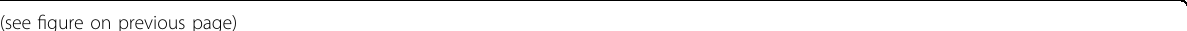
Fig. 4 ADEs promote EMT of primary tumor cells. Primary tumor cells extracted from two patients were treated with 0 μ g, 50 μ g, or 100 μ g of #7 ADEs. a Representative images of morphological changes in primary tumor cells. Scale bar, 100 μ m. b Representative images of in vitro transwell migration assays of primary tumor cells. Scale bar, 100 μ m. c The numbers of migrated cells in transwell migration assays were counted and are shown as histograms. d Representative images of in vitro wound-healing assays of primary tumor cells. Scale bar, 200 μ m. e The areas of wound closure were measured and are shown as histograms. f Representative images of in vitro colony formation assays of primary tumor cells. g The percentages of cells forming colonies are shown as histograms. h Western blot analysis of the changes in the expression of EMT markers in primary tumor cells. Experiments were performed in at least triplicate, and the results are shown as the mean ± s.d. values. Student ’ s t test was used to analyze the data (NS, not signi fi cant; * p < 0.05; ** p < 0.01; *** p <